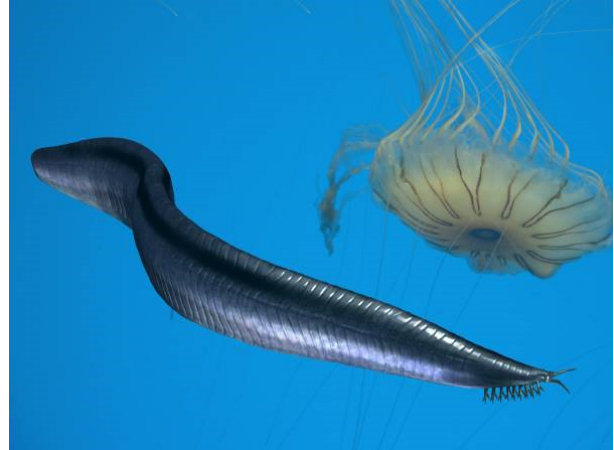
Figure 3. Pikaia gracilens . Length of animal 4 cm. Jellyfish in the background is a scyphozoan. PaleoArt credit: Nobu Tamura. Used here per CC-BY SA 4.0.